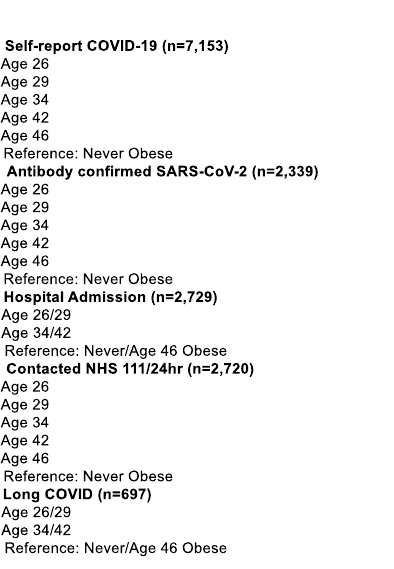
with health services, the reference category is “no admission” and “no contact”, respectively. For long COVID the reference category is “acute COVID-19”. N total represents the total number of people in each age category, whilst N case represents the number of cases within each age category. Log scale used to report Odd Ratios on X